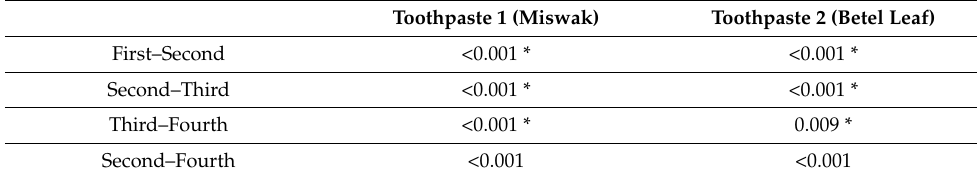
Table 2. Comparison of Plaque Index between the time points in each group.